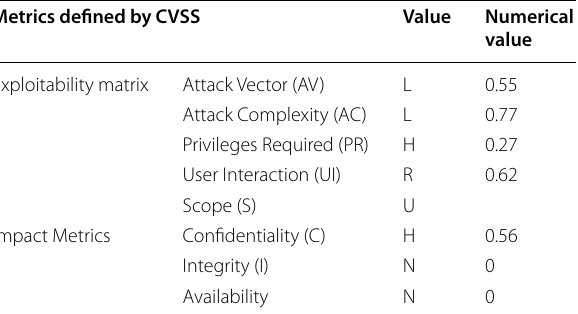
Table 1 Vulnerability rating using CVSS metrics Metrics defined by CVSS